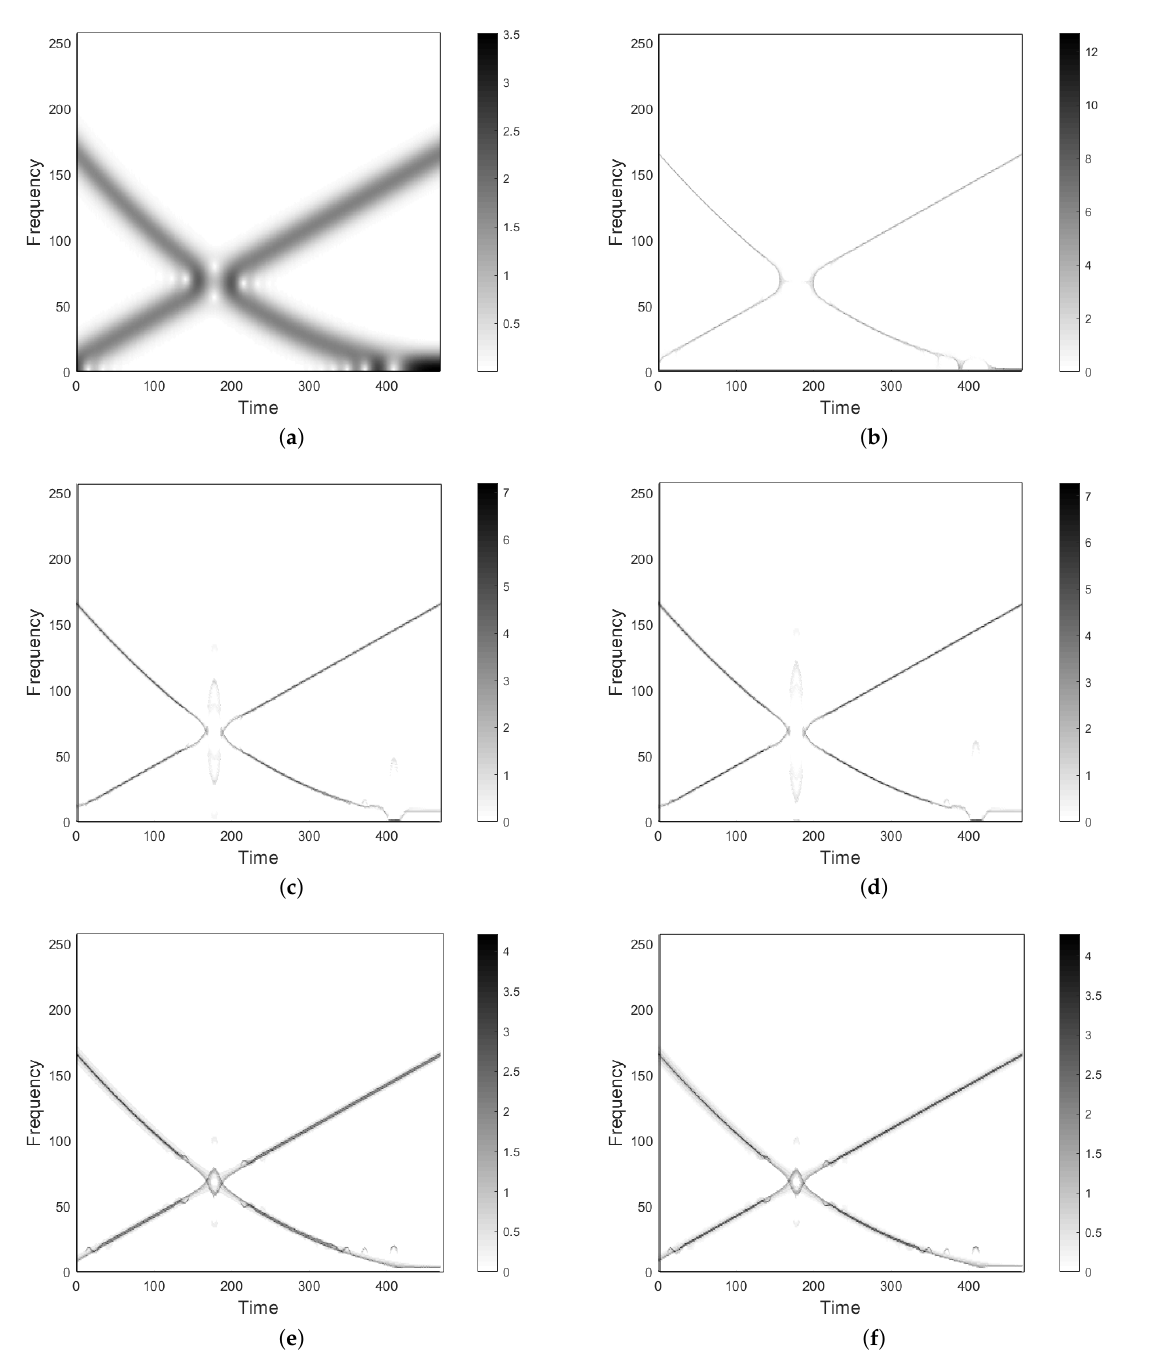
Figure 8. ( a ) Spectrogram of the two components signal in Figure 2; ( b ) Standard reassigned spectrogram; ( c ) Reassigned spectrogram using 4 iterations of FIRST —the region of incorrect or missing reassignment is smaller than the one of standard reassignment (about 50%); ( d ) Reassigned spectrogram using two iterations of FIRST —reassignment result does not change within the adopted frequency sampling step; ( e ) Reassigned spectrogram using one iteration of FIRST_K —reassignment result is comparable to the one in ( c , d ); ( f ) Reassigned spectrogram using two iterations of FIRST_K with K = 1 − 1 √ —reassignment result is comparable to the one in ( d , e 2